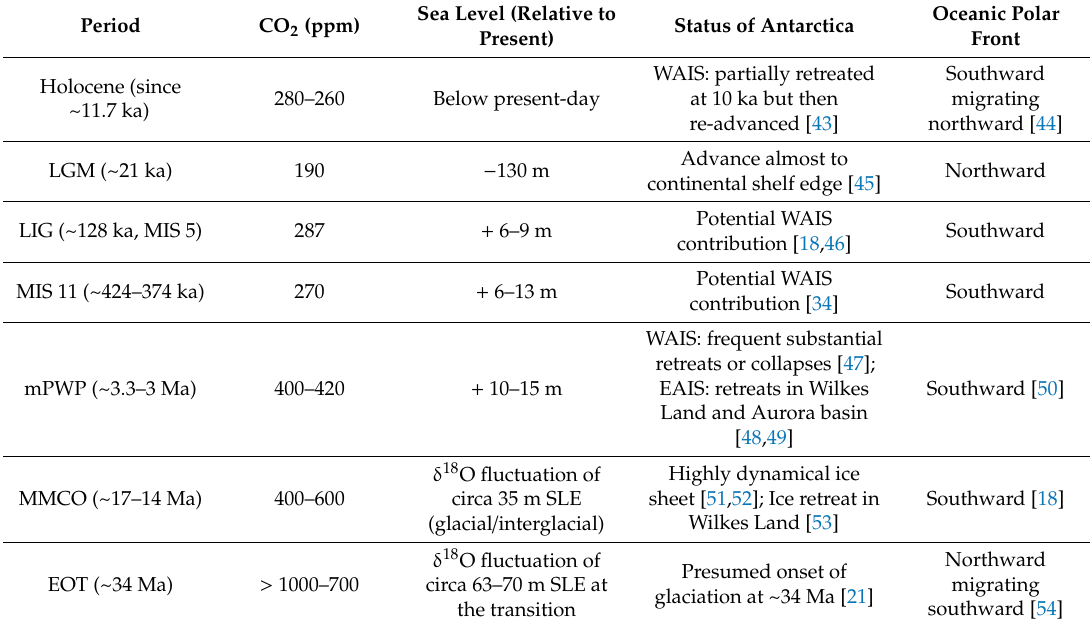
Table 1. Main features of the di ff erent periods of interest. See Figure 1 for a timeline. LGM: Last